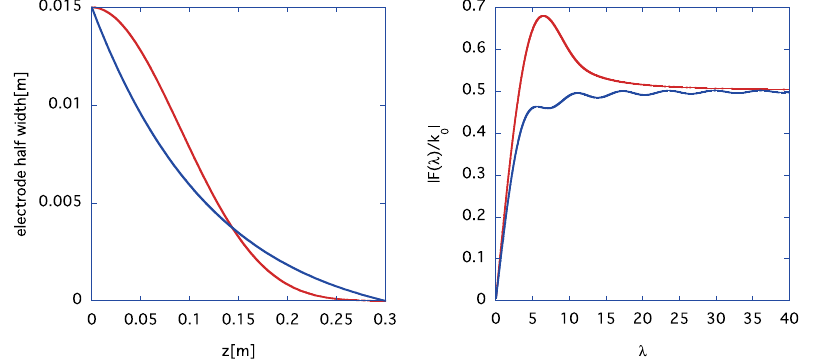
ð z Þ (blue) and that for k ð z Þ blackman-harris linnecar